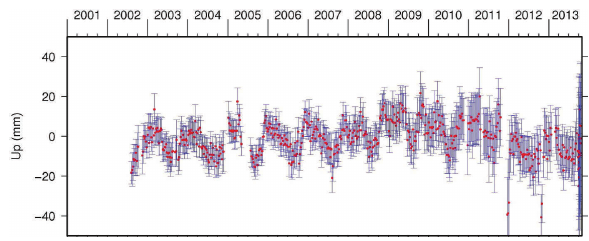
Fig. 7: Vertical position of the KIRI GPS dome according to Geo- science Australia (image from [11]). These are the raw residuals, i.e. the vertical positions de-trended vs. the linear fitting of slope − 0.7 mm/year.